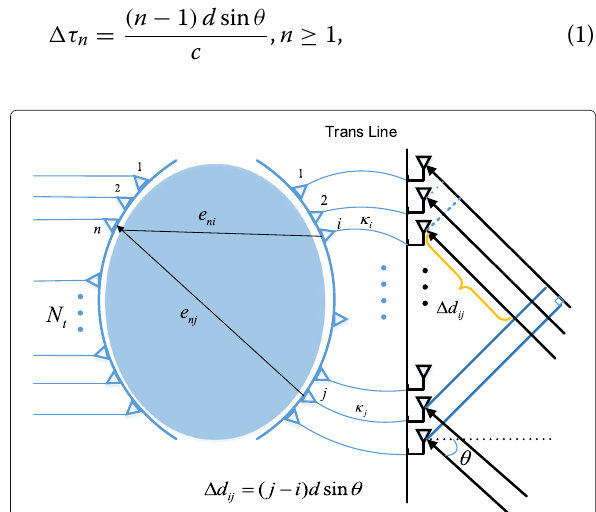
Fig. 1 The Rotman lens-based TTD